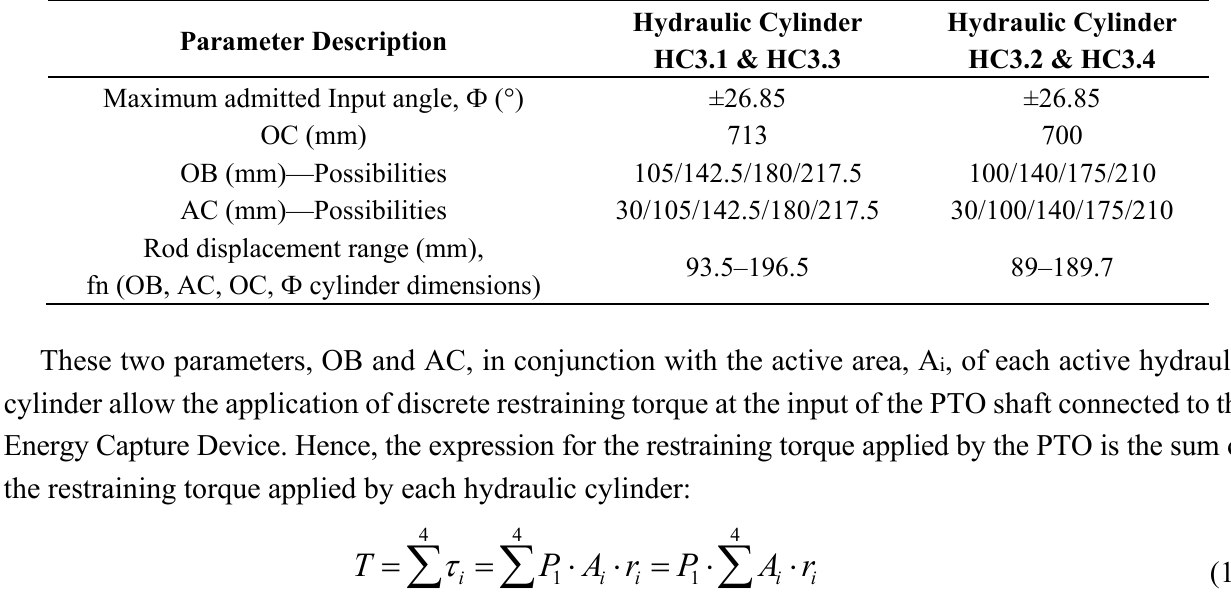
Table 1. Geometrical parameters applied to hydraulic